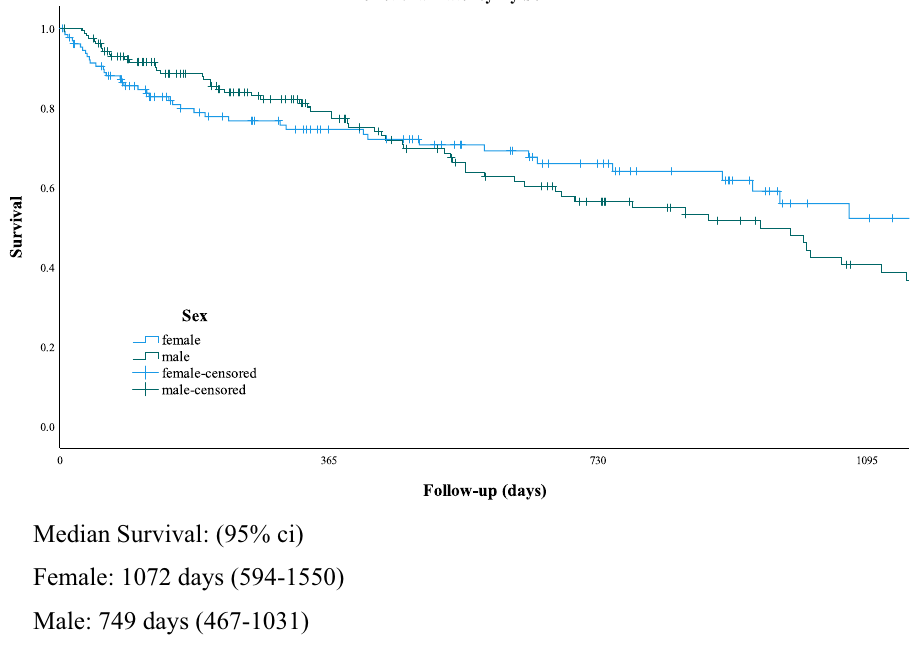
Figure 1. Kaplan–Meier survival curve of functional patency by